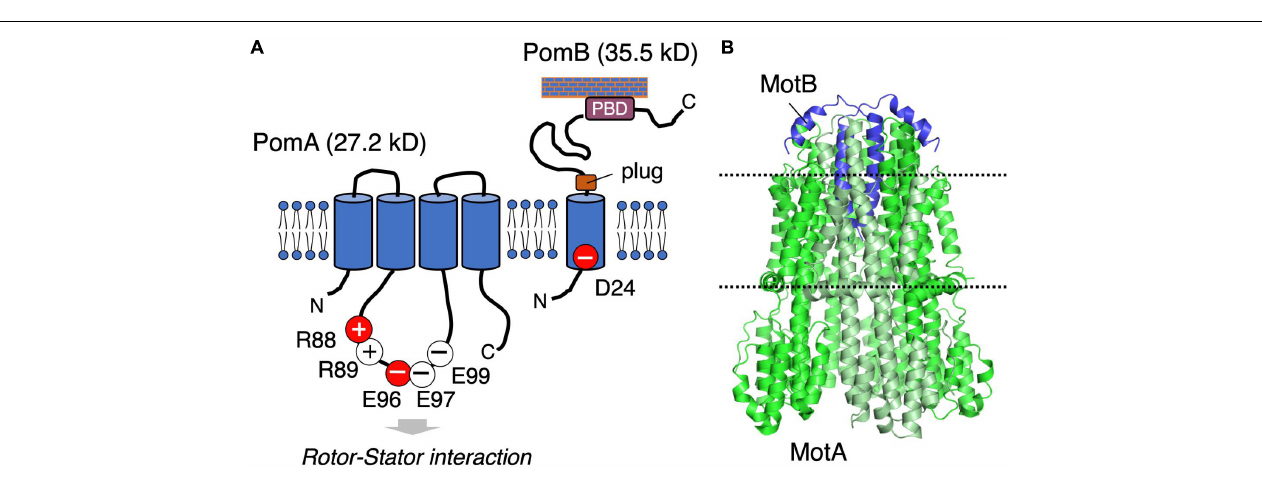
FIGURE 2 | (A) Schematic of the stator structure. The stator of the sodium-driven motor is composed of the PomA and PomB proteins. PomA has important charged residues (R88, R89, E96, E97, and E99) in the cytoplasmic loop region. PomB has the essential charged residue (D24), which is the ion-binding site. (B) The structure of the flagellar stator (PDB: 6YKM) obtained by cryo-electron microscopy is shown in a ribbon diagram with MotA green and MotB purple. The dotted lines represent the predicted boundaries of the lipid bilayer.